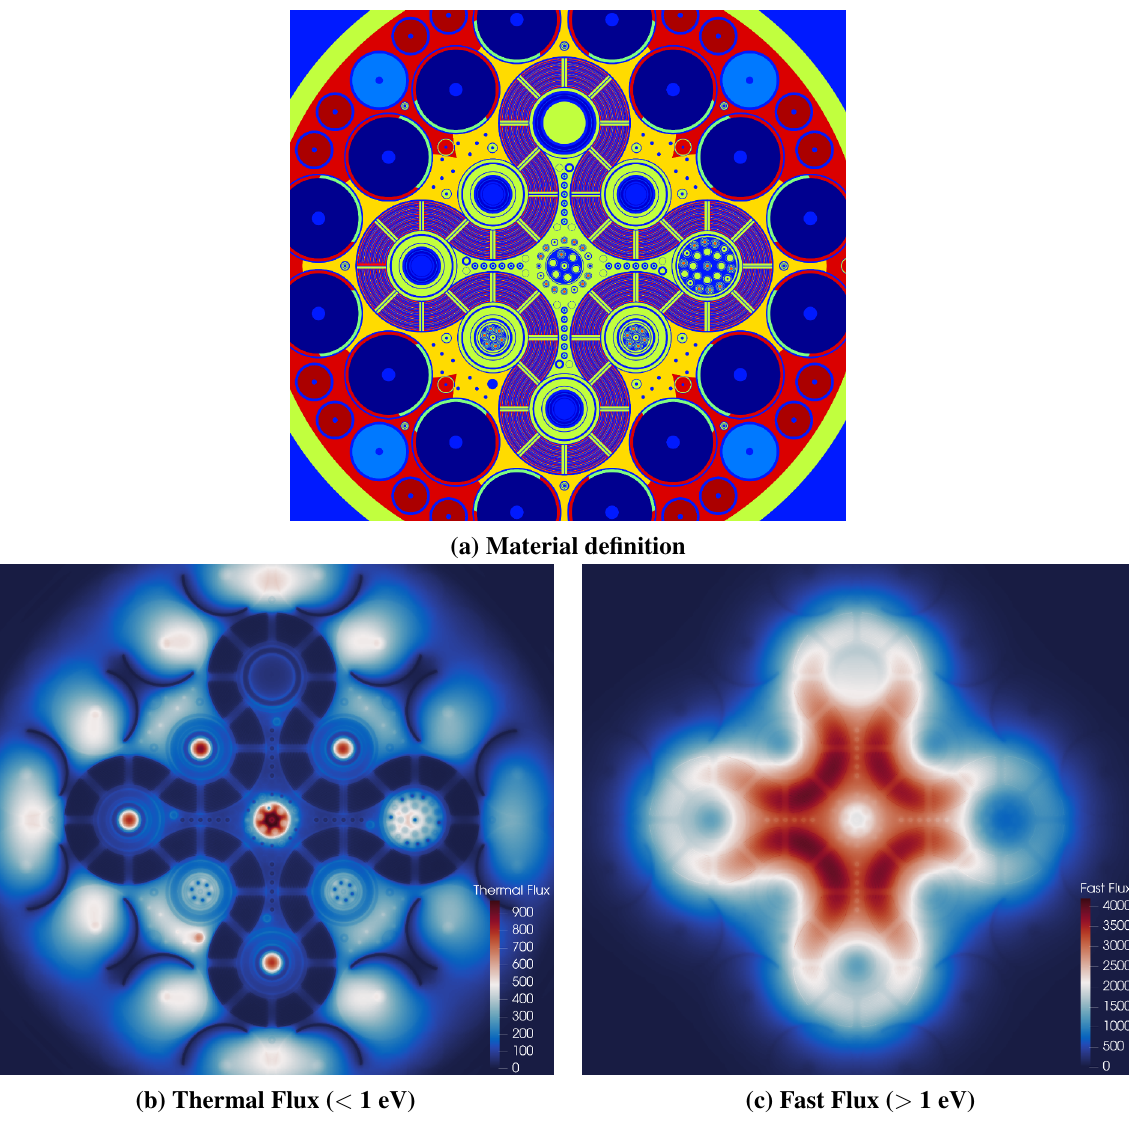
Figure 2: Material definition and flux distributions in the ATR using 800 × 800 Cartesian mesh resolution. These figures show a slightly zoomed in view towards the center of the simulation domain so as to better display the fine detail in the interior of the reactor.